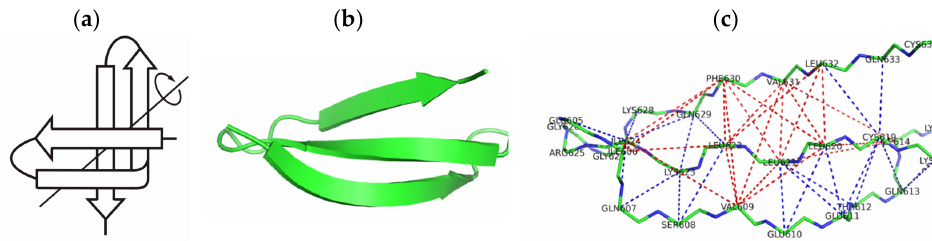
Figure 1. A schematic representation of the 3 β -corner ( a ), ribbon and wireframe model of the 3 β -corner, ( b , c ) beta-adrenergic receptor kinase 1 (bos taurus), PDB ID 1OMW region: A586-A625. Putative hydrophobic contacts are highlighted by dashed red lines, and hydrogen bonds by dashed blue lines.